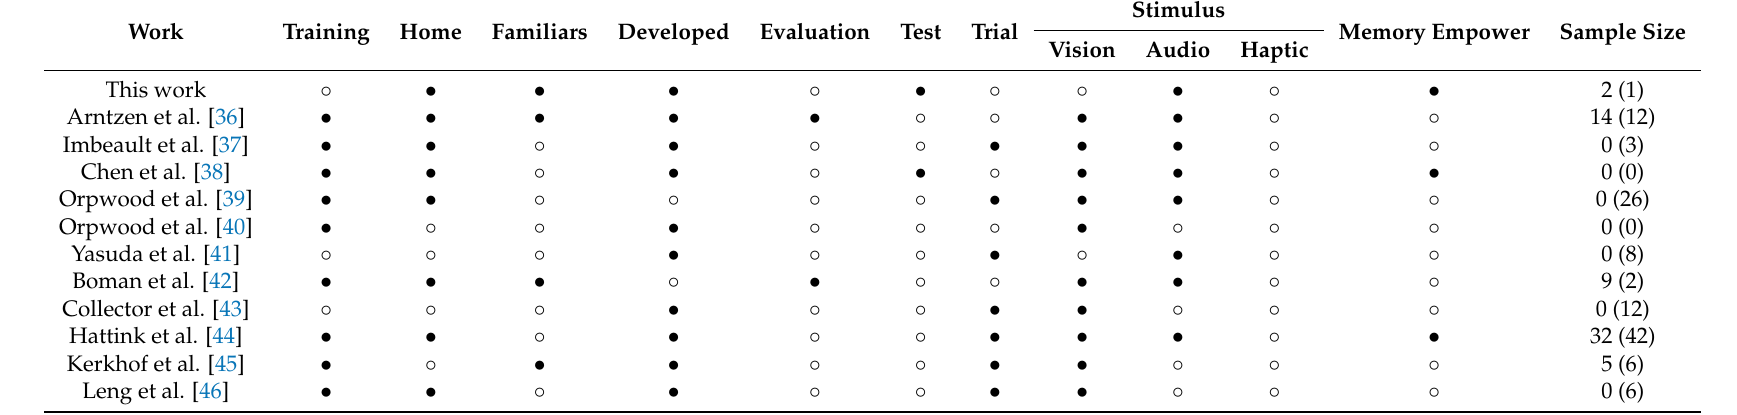
Table 4. Comparison of the proposed system to other works presented in the last 5 years. Works presented in Table 1 are also added to include works exploiting audio as a stimulus or a memory-empowerment